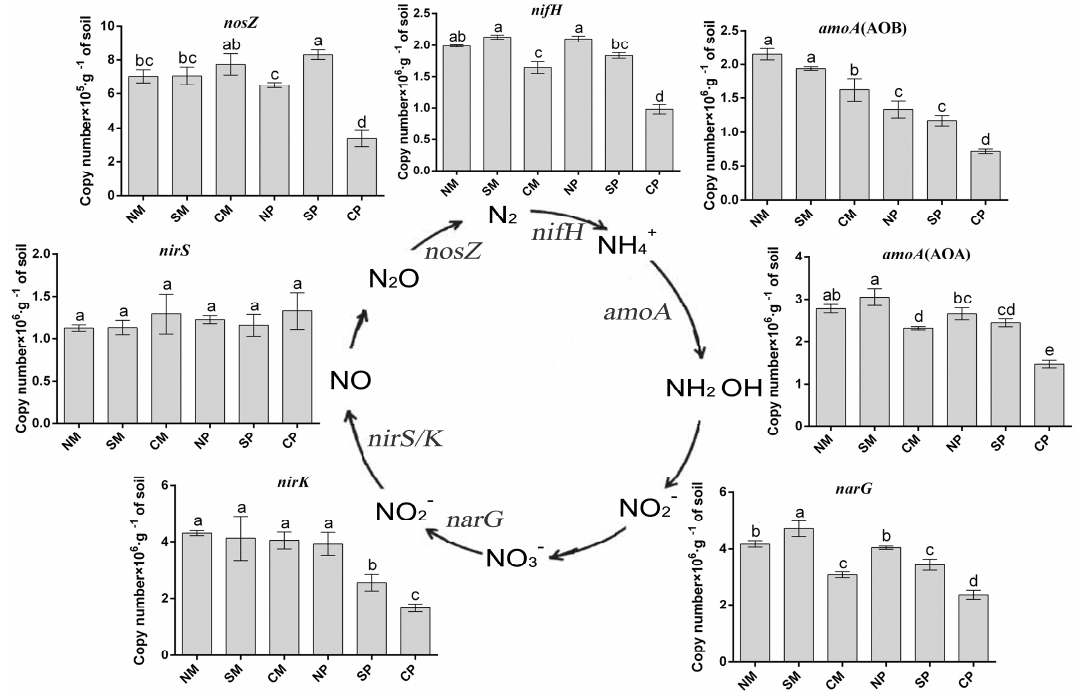
Figure 4. Quantification of genes involved in N-cycling from rhizosphere soil under different intercropping patterns. NM: non-separated maize; SM: semi-separated maize; CM: completely separated maize; NP: non-separated peanut; SP: semi-separated peanut; CP: completely separated peanut. Bars with different letters indicate significant differences (LSD’s test, p < 0.05, n = 4).